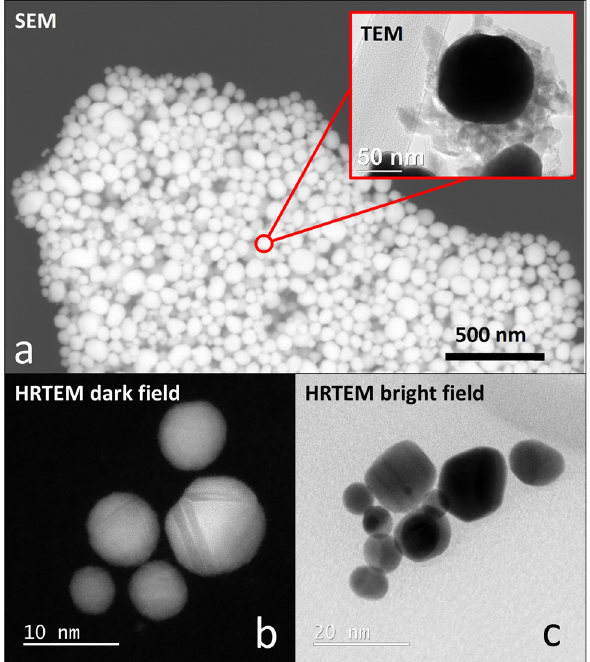
Figure 5: ( a ) SEM micrograph of PVP - stabilised AuNPs with a TEM of representative AuNP, HRTEM image of the AuNPs: ( b ) dark and ( c ) bright fi elds showing their morphology, structures, some disloca - tions, and